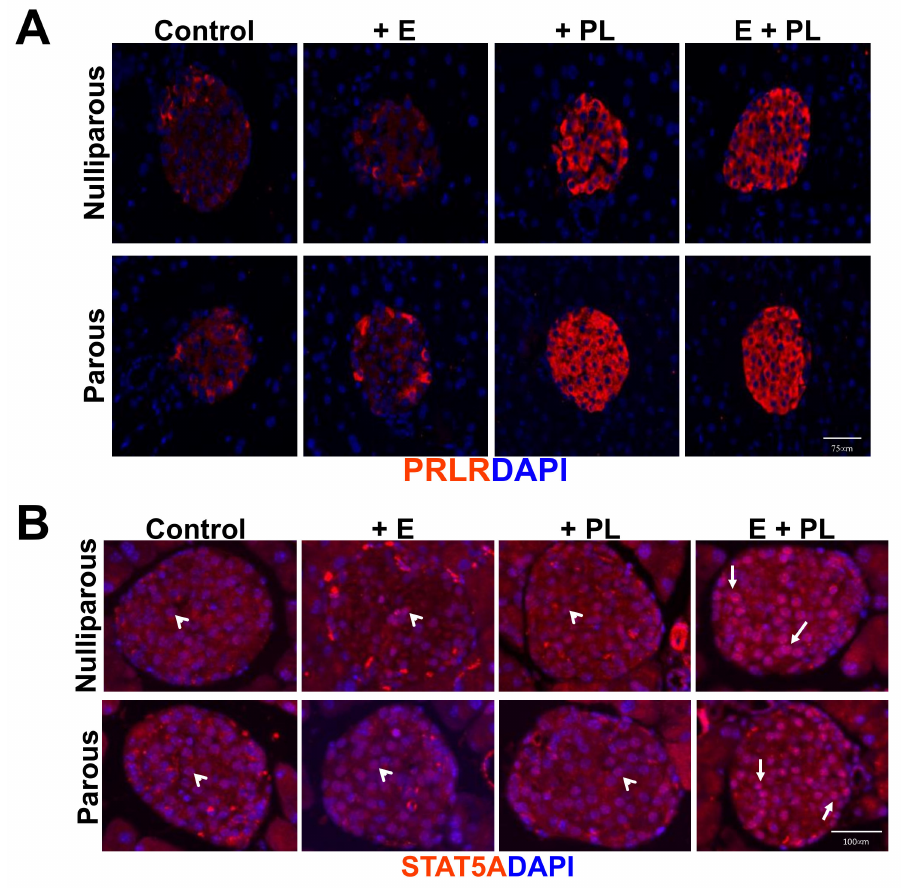
Figure 3. E + PL induce STAT5 signaling in the pseudopregnancy model. ( A ) Immunohistochemical staining for PRLR in nulliparous (top) and parous (bottom) mouse islets. ( B ) STAT5 expression in nulliparous (top) and parous (bottom) mouse islets. Open arrowheads show minimal accumulation, while white arrows show maximal